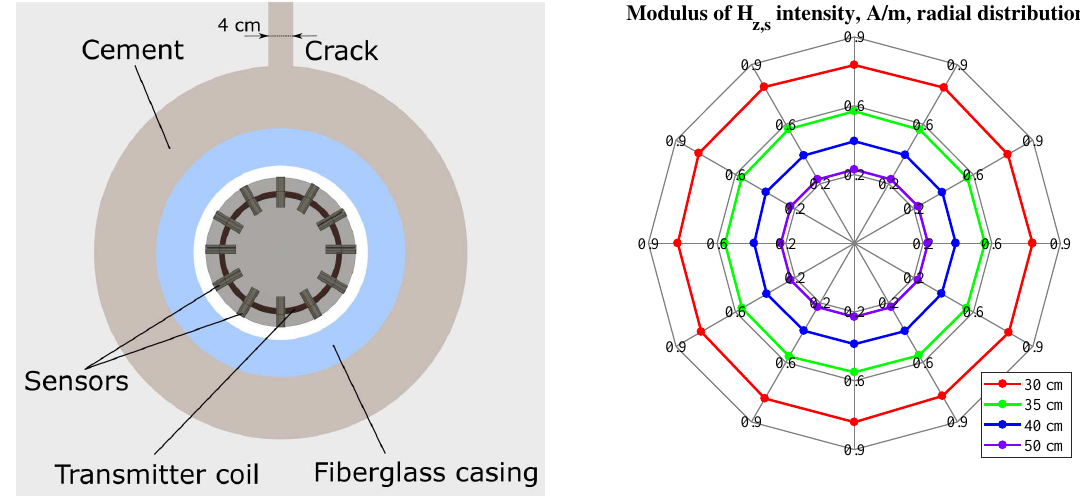
Figure 13. Facet of wellbore and crack filled with magnetic cement. The signal frequency is 1